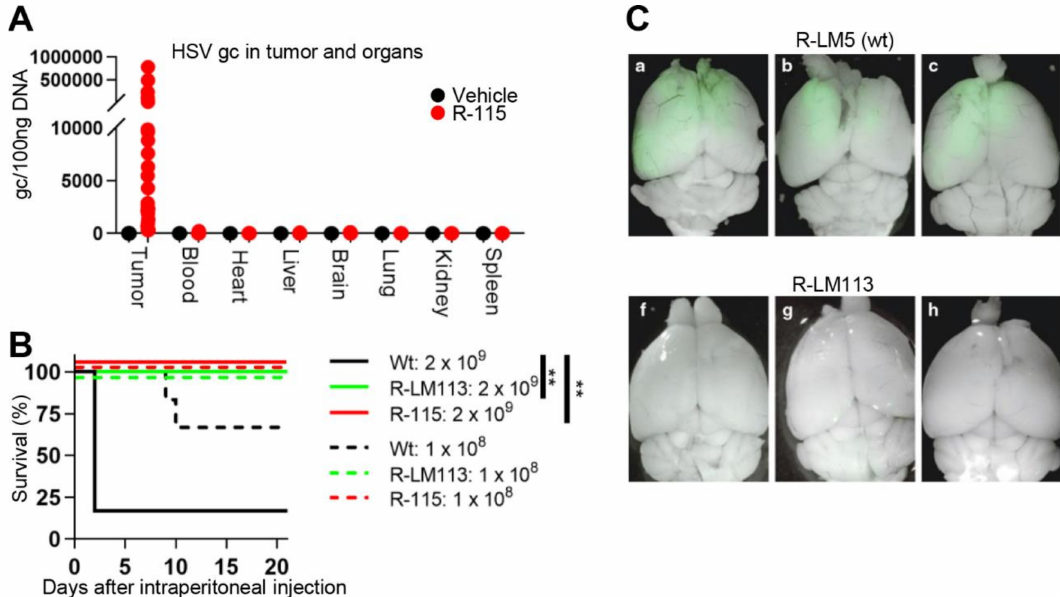
Figure 3. The retargeted oHSVs are safe in mice upon intraperitoneal, intratumoral or intracranial routes of administration. ( A ) R-115 biodistribution to the indicated organs following four intratumoral injections (1 × 10 8 PFU/dose or vehicle), started at d 10 after tumor implantation. Organs and tumors were explanted at d 26, and, after homogenization, the total DNA was extracted. R-115 genome copy numbers were determined by qPCR in comparison with a standard curve obtained with purified HSV DNA, and expressed as gc/100 ng of DNA or gc/100 µ l blood. ( B ) Kaplan Meier survival curves of the C57BL/6 mice intraperitoneally injected with 1 × 10 8 or 2 × 10 9 PFU of R-LM5 (wt HSV), R-LM113 and R-115 (1st generation) oHSVs. ( C ) Merged fluorescence and bright-field images of adult nonobese diabetic/severe combined immunodeficient (NOD/SCID) mouse brains after injection with R-LM5 (1 × 10 5 PFU) or R-LM113 (3 × 10 5 PFU) viruses. Viral spread is visualized by enhanced green fluorescent protein fluorescence. ( A ) Statistical significance was calculated using the Log-rank (Mantel-Cox) test. Panels ( A – C ), reproduced with permission. ** = p -value <